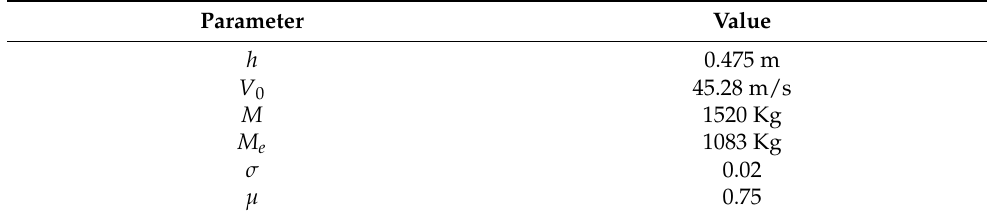
Table A5. Drop simulation settings (relevant